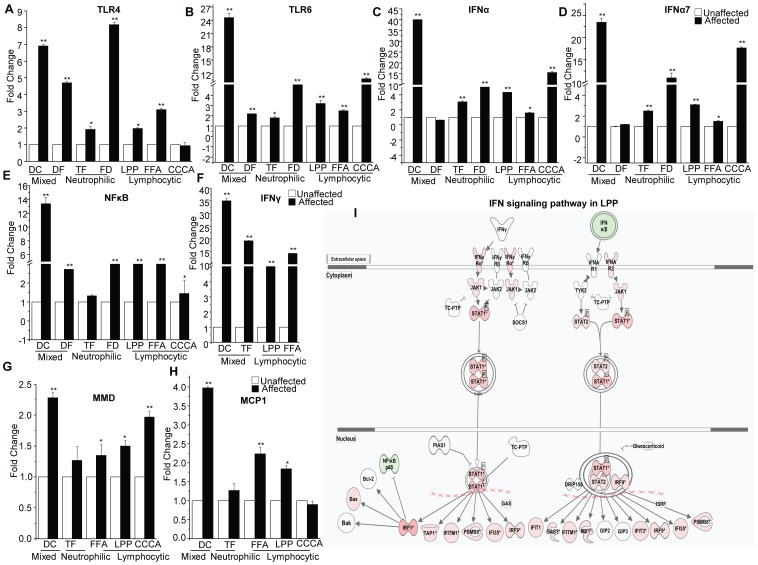
Innate immune genes are upregulated in PCA.Real-time PCR validation of (A) TLR4, (B) TLR6, (C) IFNα, (D) IFNα7, (E) NFkB, (F) IFNγ, (G) MMD and (H) MCP1 in mixed (DC, DF), neutrophilic (TF, FD) and lymphocytic (FFA, LPP, CCCA) PCA. These genes are significantly upregulated in affected tissue compared to unaffected tissue from the same patients (*p<0.05, **p<0.01). The unpaired t-test was used for statistical analysis. Differences in the pattern of expression of these genes were observed in the different PCA subtypes. (I) IPA identified the interferon signaling pathway or the “interferon-responsive signature” in the gene expression profiles of LPP. The intensity of the node color red indicates the degree of upregulation, and the intensity of the color green indicates the degree of downregulation. Genes shown as uncolored nodes were not identified as differentially expressed in our experiment and were integrated into the computationally generated networks based on the evidence stored in the IPA knowledge base, which indicated a relevance to this network. The node shapes denote enzymes, phosphatases, kinases, peptidases, transmembrane receptors, cytokines, transporters, translation factors, nuclear receptors and transcription factors. The interferon target genes IRF1, IRF8, IFNA5, IFNAR2, IFIT3, IFITM1, MX1, OAS1 and IFI35 are significantly upregulated in LPP. See also Table S2.